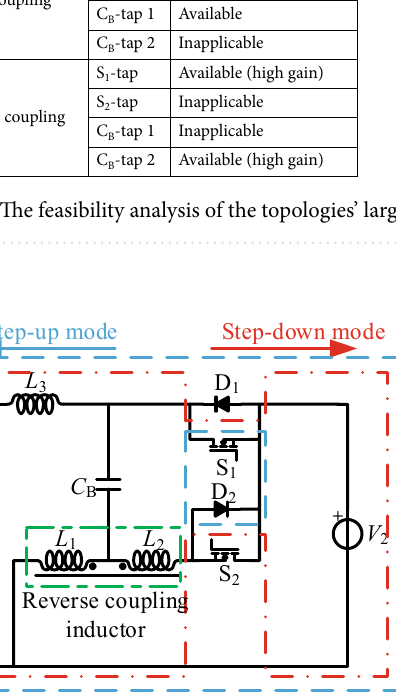
Figure 6. A reverse coupling tapped-inductor high gain bidirectional Cuk